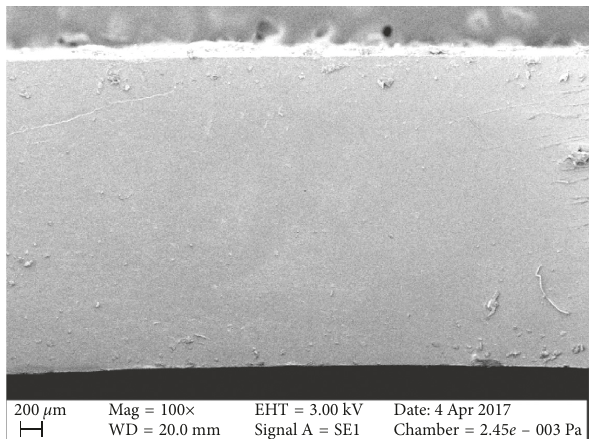
Figure 5: Impact fracture surface of pure epoxy